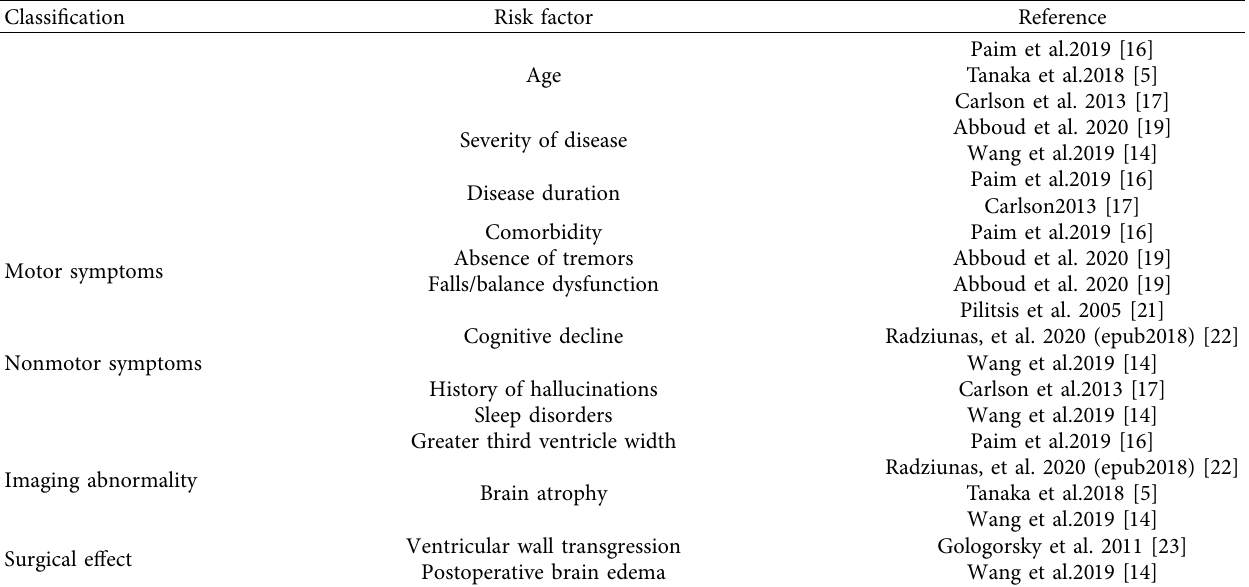
Table 2: Risk factors associated with delirium following